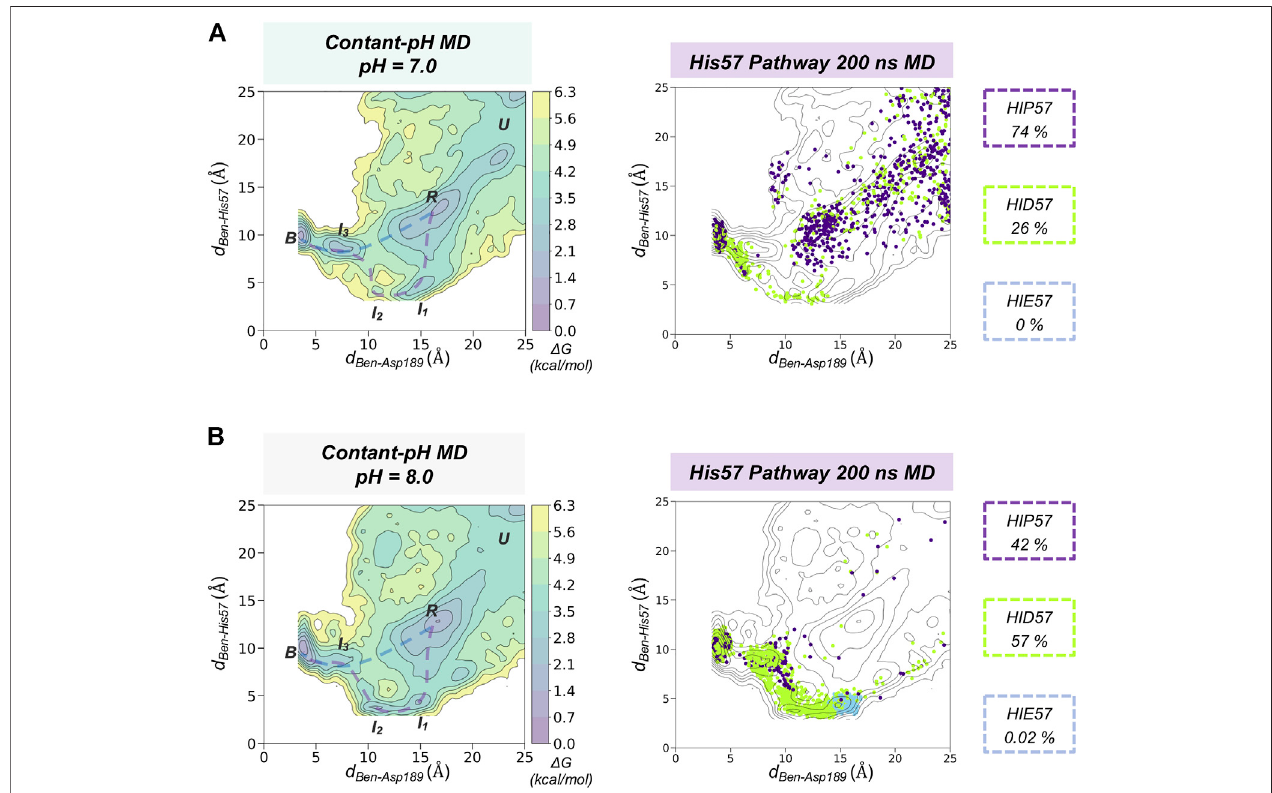
FIGURE4| SpontaneousBenzamidineBindingwithConstant-pHMolecularDynamicsSimulations.Freeenergylandscape(FEL)reconstructedfrom30replicasof 200 nsofspontaneousbindingconstant-pHMDsimulationsatpH=7.0 (A) andpH=8.0 (B) usingthebindingdistance( d Ben-Asp189 , x axis)betweenthecarbonatomof the amidine group of benzamidine and the carbon of the carboxylate group of Asp189 and the distance between the carbon atom of the amidine group of benzamidine andtheepsilonnitrogenofHis57( d Ben-His57 , y axis).ThemostrelevantstatesoftheFELarehighlightedinblackboxes: U (unbound), R (recognition), B (bound)and I (intermediate) states. Projection of a representative 200 ns trajectory of the His57 pathway showing the protonation state of each frame in different colour: HID in green, HIP in purple, and HIE in blue. The equilibrium populations of each protonation state retrieved from the 30 replicas of 200 ns is provided for pH = 7.0 and